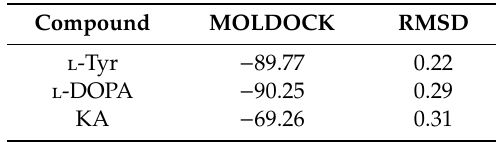
Table 1. MOLDOCK scoring (in kcal/mol) and RMSD (in Å) values for re-docking procedures. Compound MOLDOCK